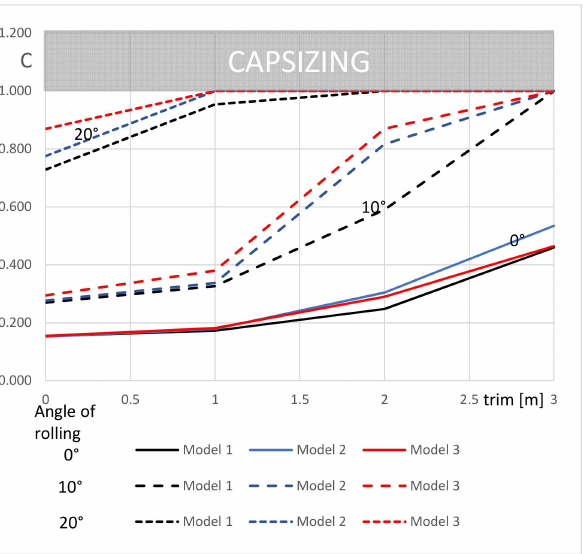
Figure 8. Values of the vessel’s capsizing coefficient (C) depending on the trim and its